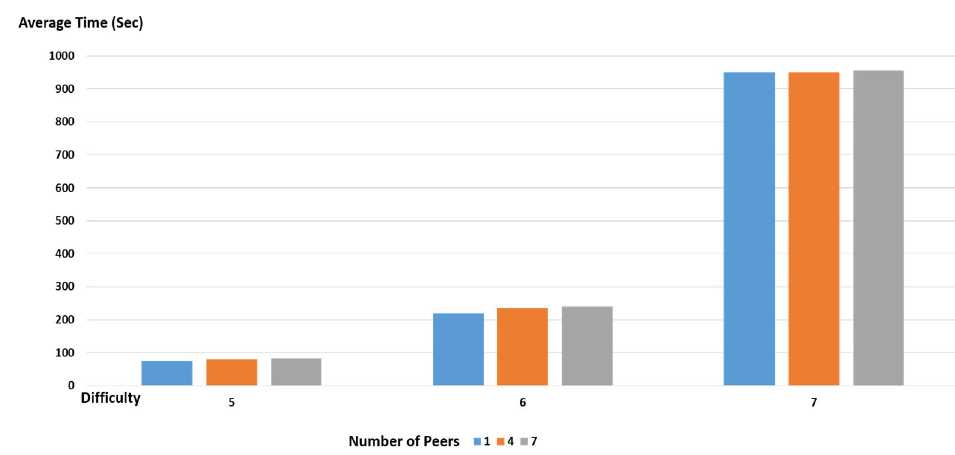
Figure 8. First Scenario Results (Solo